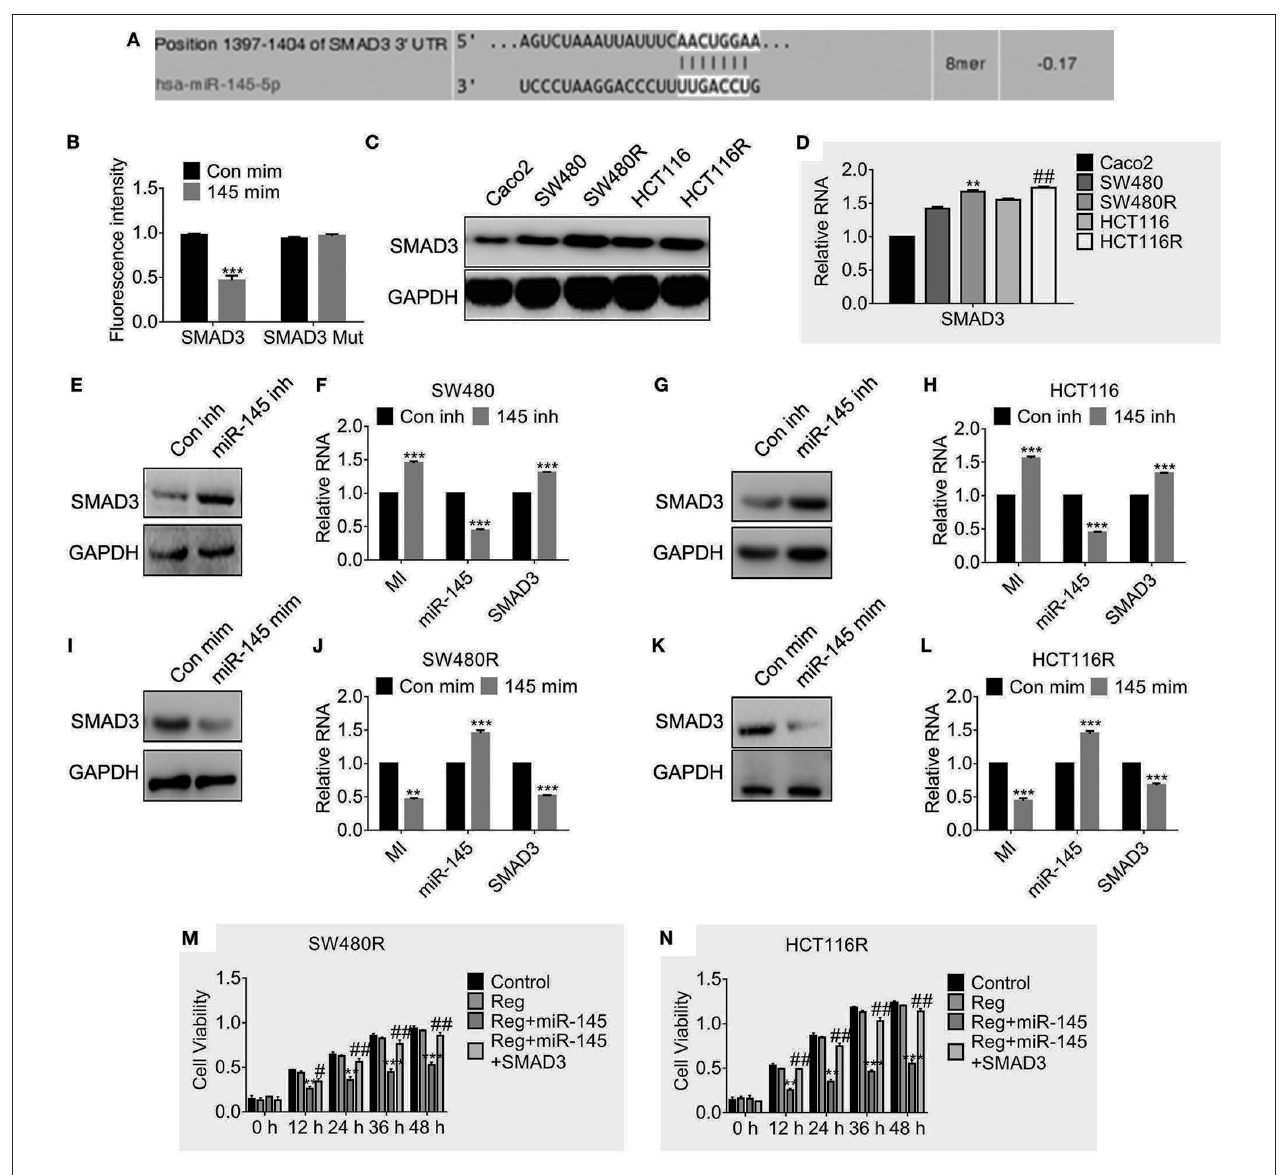
FIGURE 4 | miR-145 targets SMAD3 and deregulated SMAD3-enhanced viability. (A) Schematic diagram of predictive binding sites of miR-145 and SMAD3. (B) Dual-luciferase activity of SMAD3 promotor. SMAD3, SMAD3 wild type 3 ′ -UTR; SMAD3 MUT, SMAD3 mutant 3 ′ -UTR. (C,D) The expression of SMAD3 in the indicated cells were accessed by western blot and qRT-PCR, separately. ** P < 0.05, vs. SW480. ## P < 0.05, vs. HCT116. (E–H) The expression of SMAD3, MIR570MG and miR-145 in the indicated cells expressing miR-145 inhibitor. inh, inhibitor. *** P < 0.001, vs. control. (I–L) The expression of SMAD3, MIR570MG and miR-145 in the indicated cells expressing miR-145 mimic. mim, mimic. *** P < 0.001, vs. control. (M,N) The cell viability of the indicated cells was accessed by the MTT assay. Cells expressing miR-145 or miR-145 plus SMAD3 were exposed to 1 µ M regorafenib. MTT assay was performed post-treatment at the indicated time-point. ** P < 0.01, *** P < 0.001, vs. regorafenib; ## P < 0.01, vs. miR-145 exposed to Regorafenib. Data obtained from independent experiments thrice. Con mim, control mimic; 145 mim, miR-145 mimic; Con inh, control inhibitor; Reg, 1 µ M regorafenib